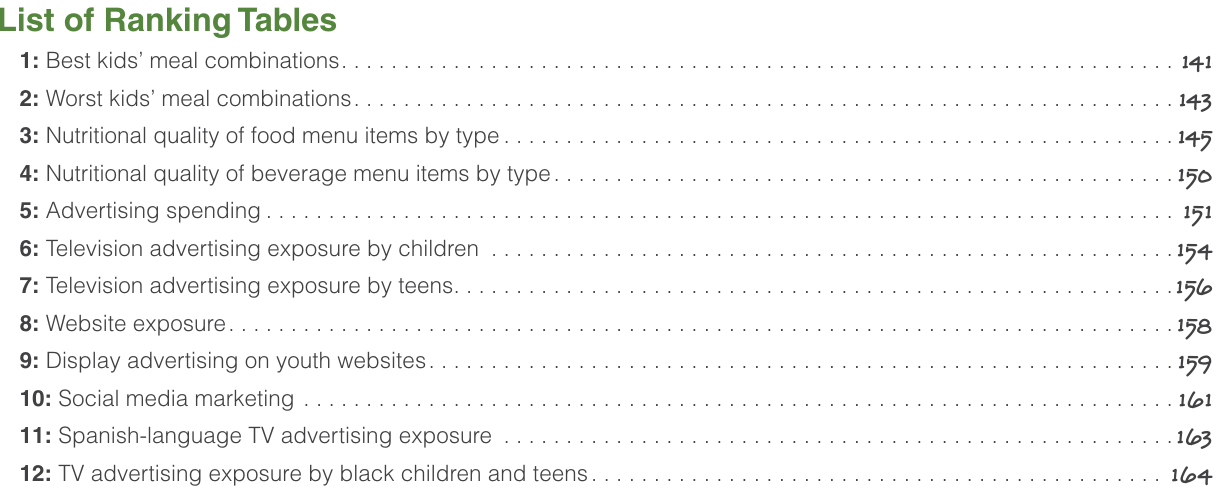
Figure 1: Percent of kids’ meals that met various nutrition standards for children . . . . . . . . . . . . . . . . . . . . . . . . . . . . . 18 Figure 2: Number of menu items offered by type for the top-five restaurants. . . . . . . . . . . . . . . . . . . . . . . . . . . . . . . . 20 Figure 3: Percent of menu items by type that met nutrition criteria. . . . . . . . . . . . . . . . . . . . . . . . . . . . . . . . . . . . . . . . . 21 Figure 4: Percent of menu items by restaurant that met nutrition criteria . . . . . . . . . . . . . . . . . . . . . . . . . . . . . . . . . . . . 21 Figure 5: Percent of items that met all nutrition criteria from full menus and special menus . . . . . . . . . . . . . . . . . . . . 26 Figure 6: Total fast food advertising spending . . . . . . . . . . . . . . . . . . . . . . . . . . . . . . . . . . . . . . . . . . . . . . . . . . . . . . . . 31 Figure 7: Trends in exposure to TV advertising for all fast food restaurants by age group. . . . . . . . . . . . . . . . . . . . . . . 32 Figure 8: TV advertising exposure by restaurant and age group . . . . . . . . . . . . . . . . . . . . . . . . . . . . . . . . . . . . . . . . . . 32 Figure 9: Trends in exposure to TV advertising by restaurant and age group . . . . . . . . . . . . . . . . . . . . . . . . . . . . . . . . 33 Figure 10: Messages in advertising for kids’ meals on children’s TV networks . . . . . . . . . . . . . . . . . . . . . . . . . . . . . . . 37 Figure 11: Messages in advertising for other products on children’s TV networks. . . . . . . . . . . . . . . . . . . . . . . . . . . . 38 Figure 12: Calories viewed daily in TV ads for fast food restaurants . . . . . . . . . . . . . . . . . . . . . . . . . . . . . . . . . . . . . . 42 Figure 13: Average number of posts per week on restaurants’ Facebook pages . . . . . . . . . . . . . . . . . . . . . . . . . . . . 56 Figure 14: Social media footprint. . . . . . . . . . . . . . . . . . . . . . . . . . . . . . . . . . . . . . . . . . . . . . . . . . . . . . . . . . . . . . . . . . . 61 Figure 15: Trends in exposure to TV advertising on Spanish-language TV by age group . . . . . . . . . . . . . . . . . . . . . . 64 Figure 16: Average number of ads viewed on Spanish-language TV. . . . . . . . . . . . . . . . . . . . . . . . . . . . . . . . . . . . . . 64 Figure 17: Calories viewed daily by black children and teens in TV ads for fast food . . . . . . . . . . . . . . . . . . . . . . . . . 67 Figure 18: Advertising spending for fast food restaurants versus healthy food categories . . . . . . . . . . . . . . . . . . . . . . 72 Figure 19: Empty calories in kids’ meal combinations . . . . . . . . . . . . . . . . . . . . . . . . . . . . . . . . . . . . . . . . . . . . . . . . . . 73 Figure 20: Empty calories in regular menu meals . . . . . . . . . . . . . . . . . . . . . . . . . . . . . . . . . . . . . . . . . . . . . . . . . . . . . .